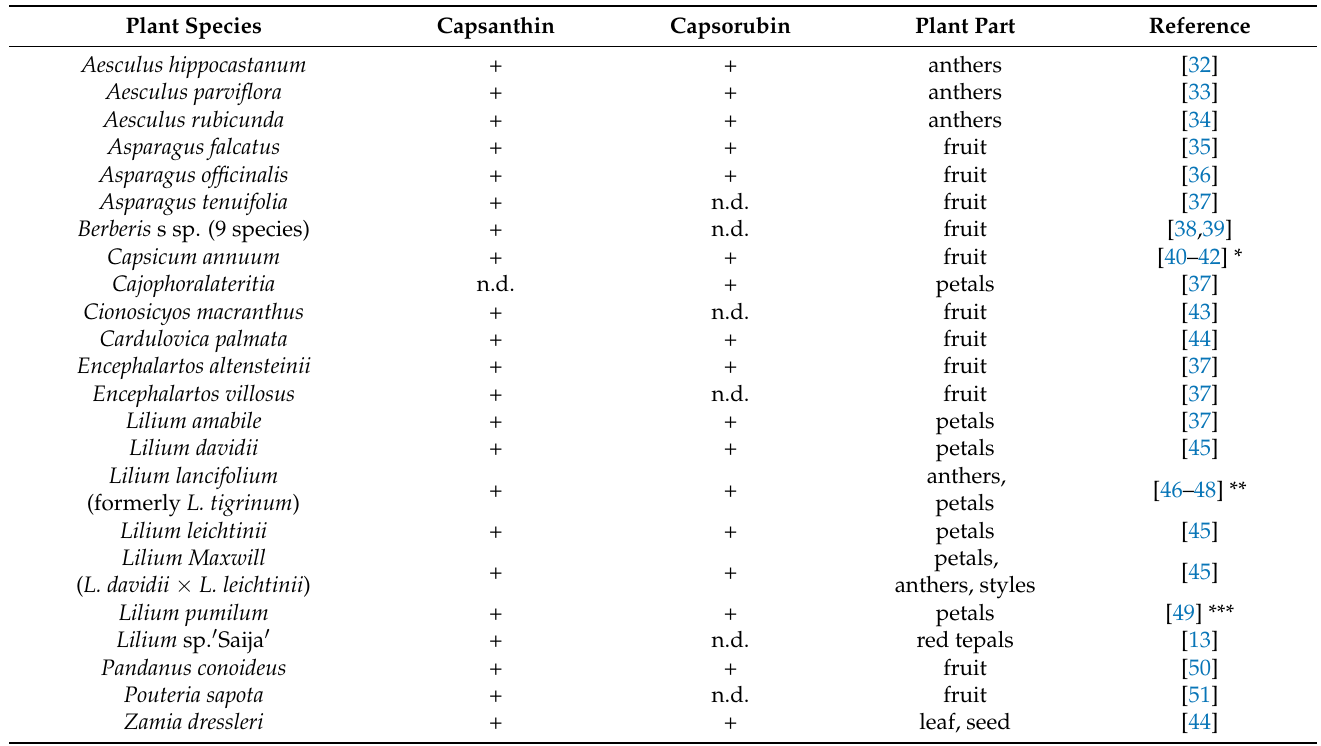
Table 1. The list of plant species that synthesize and accumulate capsanthin and/or capsorubin in different plant parts and of those from which the capsanthin/capsorubin synthase genes were cloned.